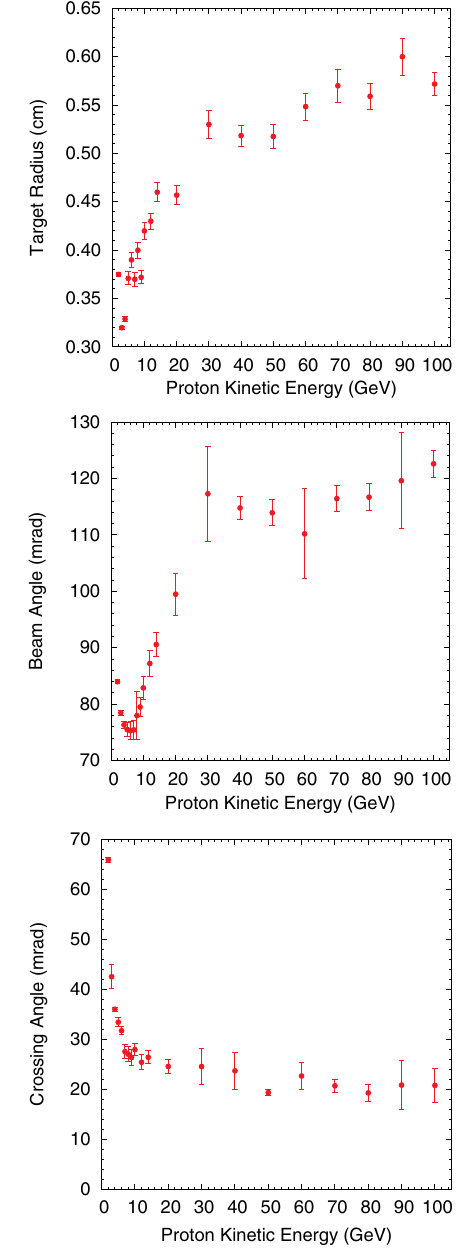
FIG. 6. Optimized target parameters of target radius (top), beam angle at z ¼ (cid:2) 75 cm (middle), and beam/jet crossing angle at z ¼ (cid:2) 37 : 5 cm (bottom) as a function of proton kinetic energy.